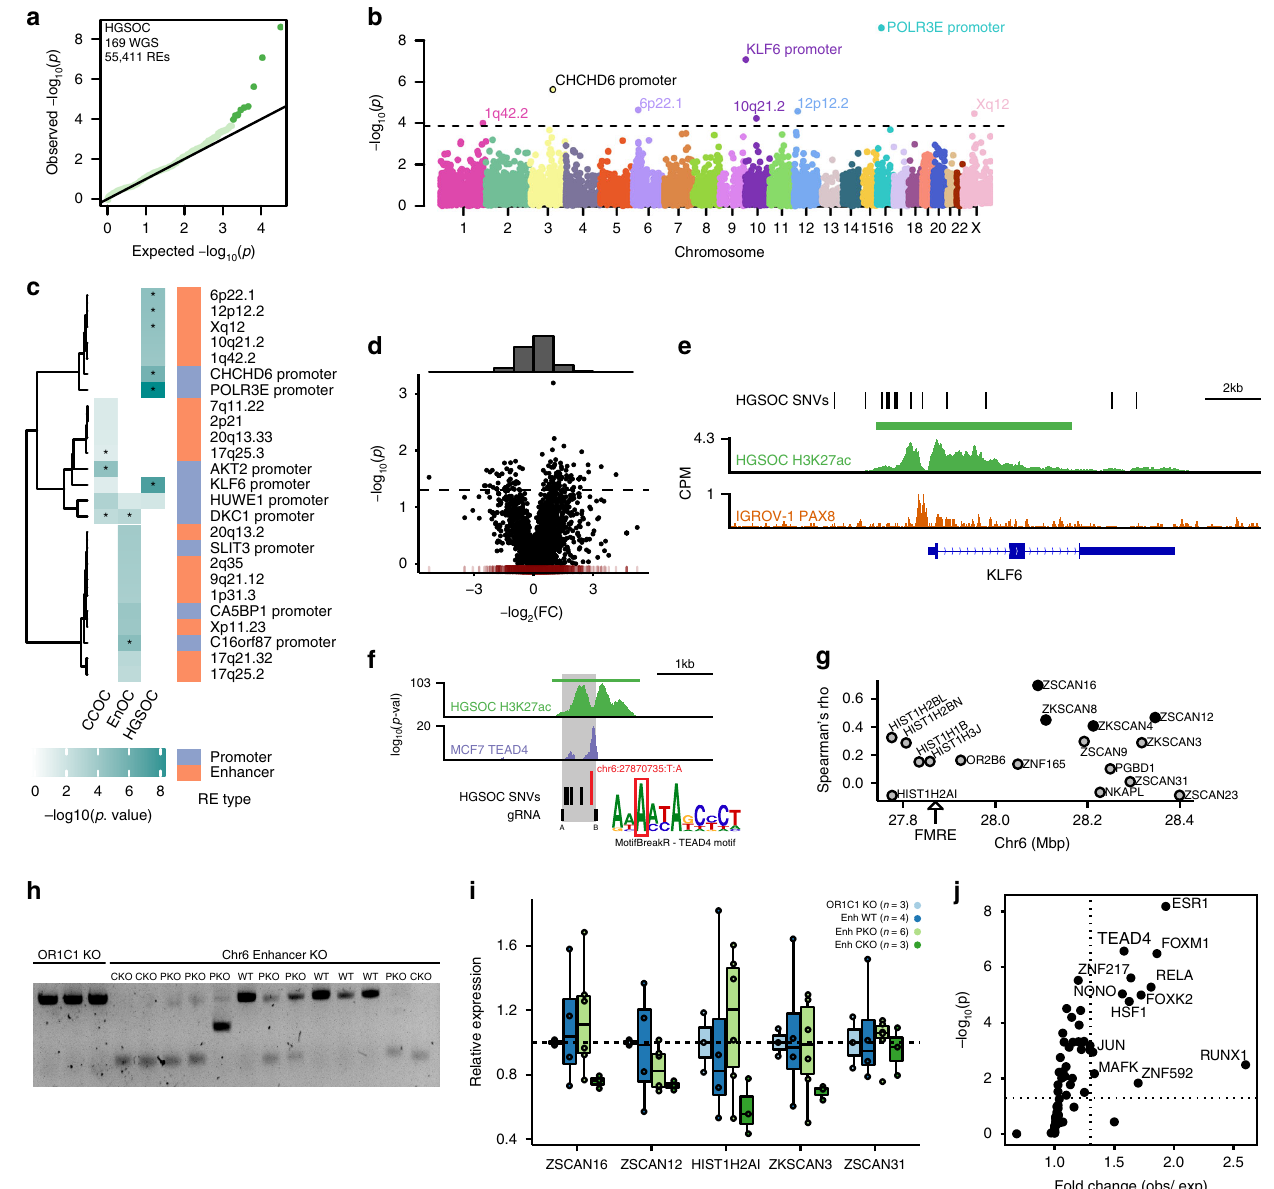
Fig. 3 Frequently mutated regulatory elements (FMREs) in OC. a QQ-plot that shows the expected ( x -axis) and observed ( y -axis) signi fi cance values of the mutational burden for all active REs in HGSOC. b Manhattan plot that shows the genomic location ( x -axis) and signi fi cance value ( y -axis) of the mutational burden for all active REs in HGSOC. c Heatmap that shows the mutational burden ( P -value) of the 25 FMREs across CCOC, EnOC, and HGSOC; asterisks represent FDR ≤ 10%. d Volcano plot that shows the fold change of median gene expression ( x -axis) and the signi fi cance value ( y -axis) of the putative target gene of samples with overlapping single nucleotide variants in an active RE vs. wild-type samples. The histogram on top of the scatterplot shows more overexpression events ( − log2(FC)> 0) in the presence of single nucleotide variants than under expression events ( − log2(FC) < 0). e The KLF6 locus, location of SNVs, SE, and PAX8-binding sites. f The 6p22.1 mutated enhancer, location of SNVs, TEAD4-binding sites and motif logo relative shows position of the recurrent mutation g Spearman ’ s rho correlation between the activity of a FMRE (6p22.1 enhancer) and nearby genes. h and i Single- cell-derived clones after CRISPR/Cas9-mediated deletion in the SHIN3 HGSOC cell line. h Gel electrophoresis showing the genotype of the 16 clones (3 OR1C1 control knockouts (KO), 4 wild type (WT), 6 partial KO (PKO), and 3 complete KO (CKO)). i Relative expression of ZSCAN16 , ZSCAN12 , HIST1H2AI , and ZSCAN31 in the 16 clones. j Fold change and P -value of the enrichment of HGSOC somatic SNVs in active TF-binding sites using publicly available MCF-7 TF ChIP-seq